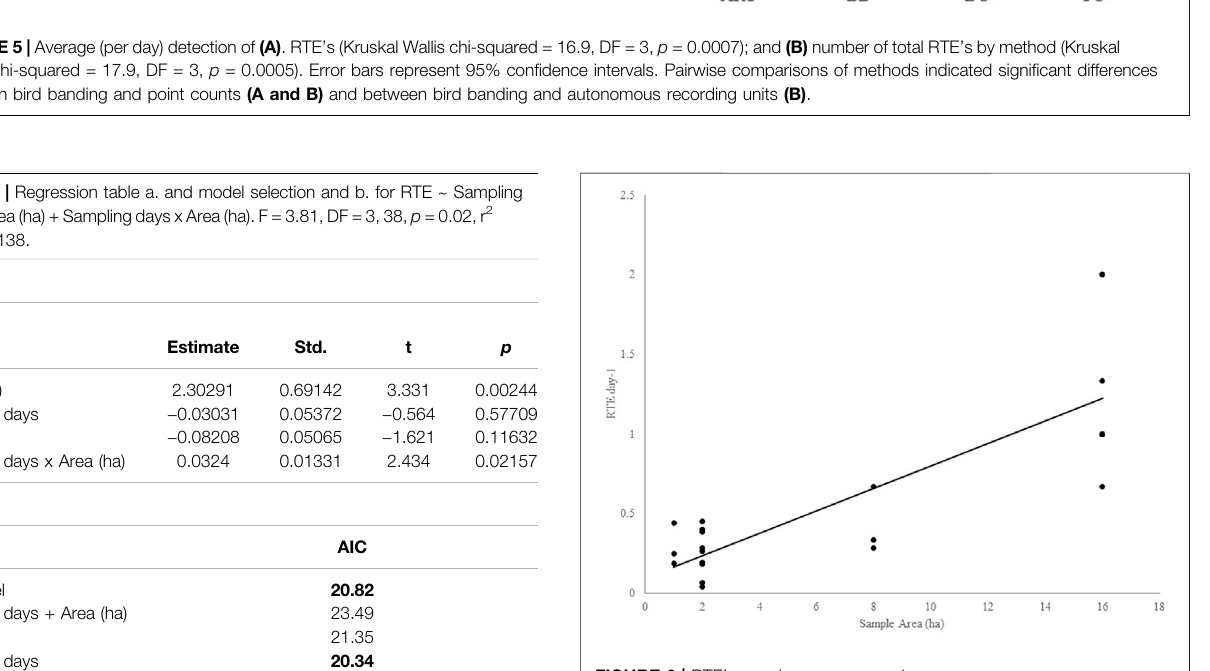
FIGURE 6 | RTE ’ s per day across sample